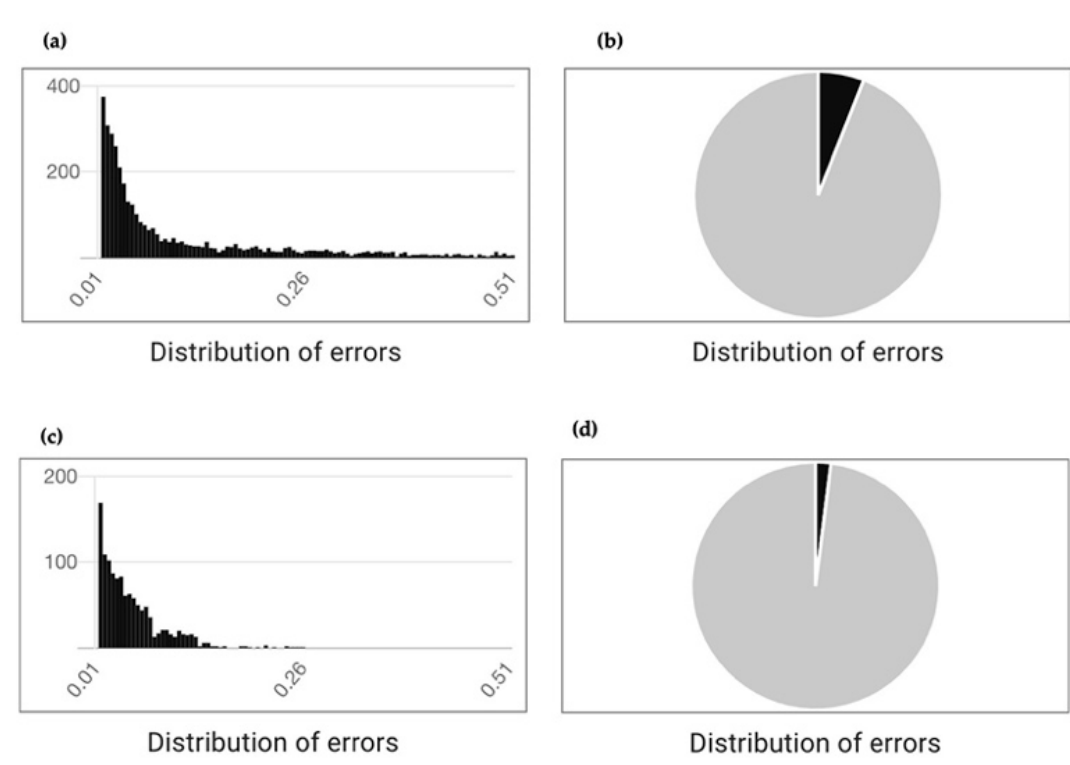
Figure 5. Display of a Sandtank-ML application run, showing the distribution of errors outputs for ( a ) a dry dataset pressure output, ( b ) a dry dataset saturation output, ( c ) an all dataset pressure output, and ( d ) an all dataset saturation output.